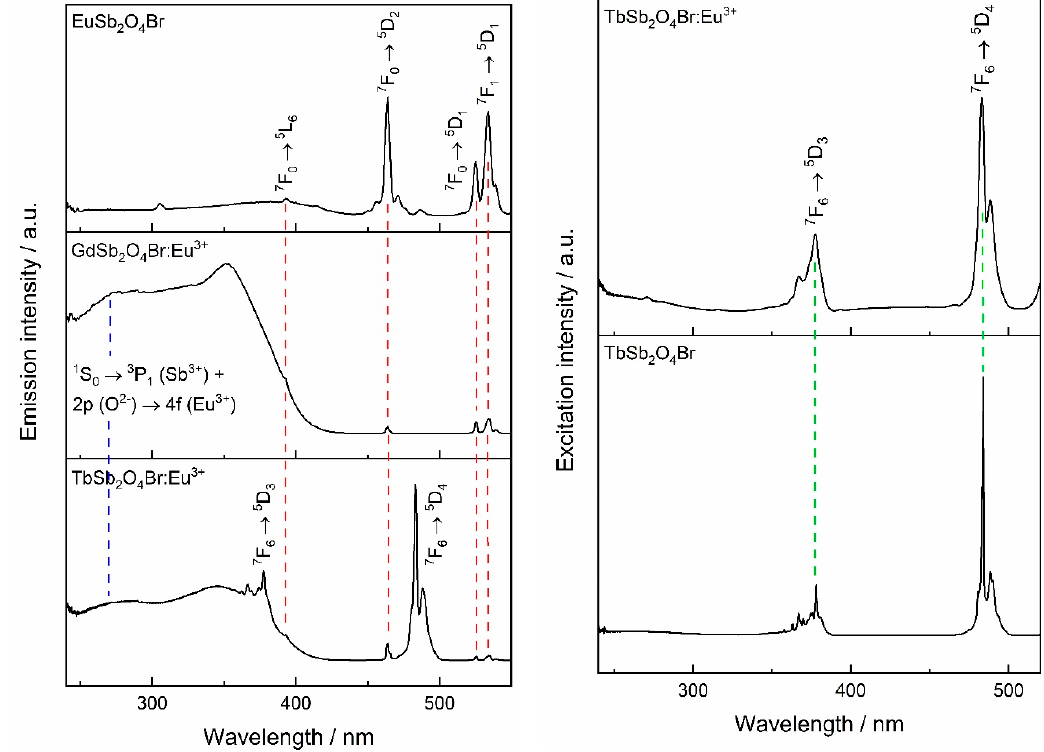
Figure 12. Left : excitation spectra of Eu 3 + -containing Ln Sb 2 O 4 Br compounds ( Ln = Eu–Tb), monitored at λ em = 611 nm. Right : excitation spectra of Tb 3 + -based compound TbSb 2 O 4 Br, monitored at λ em = 541 nm.